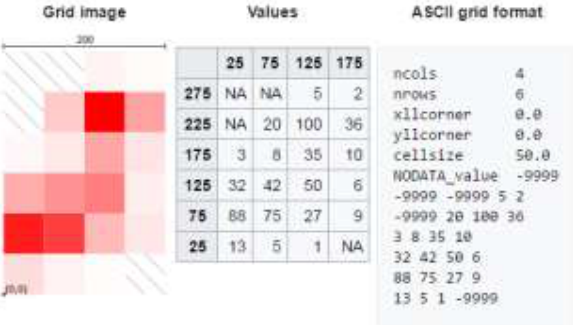
Figure 2 . ESRI GRID format (from Wikipedia,